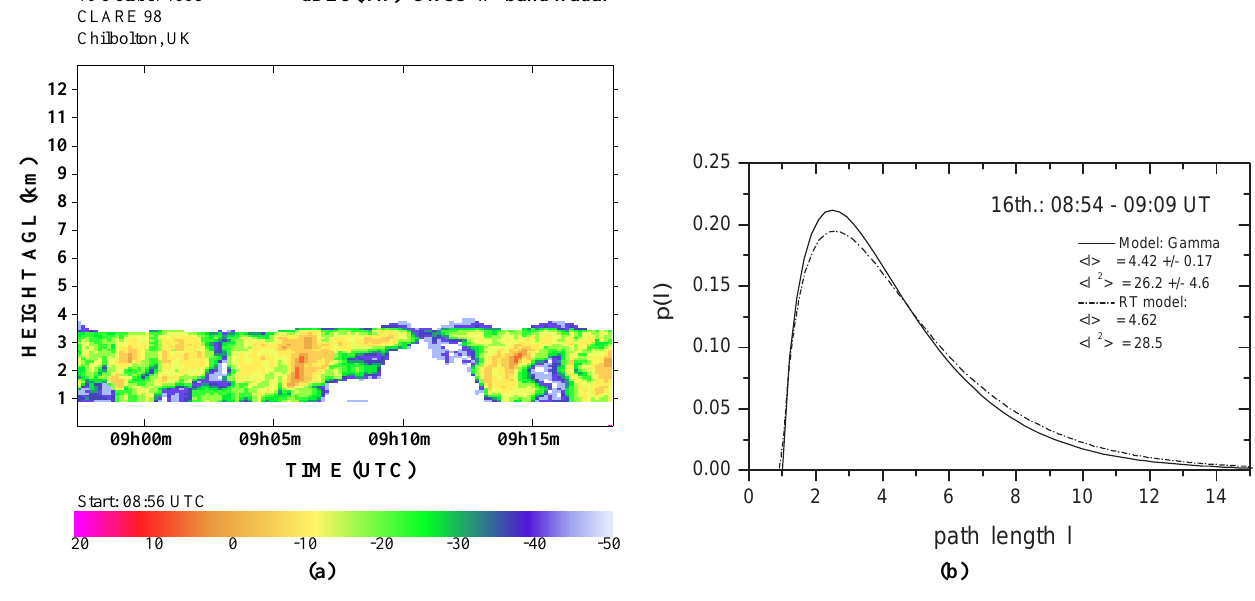
Fig. 7. (a) Cloud structure for an inhomogeneous cumulus cloud field. (b) PPDs derived from the measurement and from the 1-D RT model. Both distributions agree within the